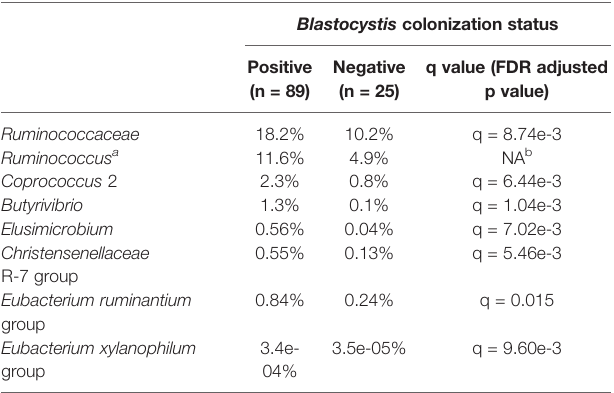
TABLE 1 | Mean relative abundances of various bacterial families and genera in Blastocystis -positive and Blastocystis -negative